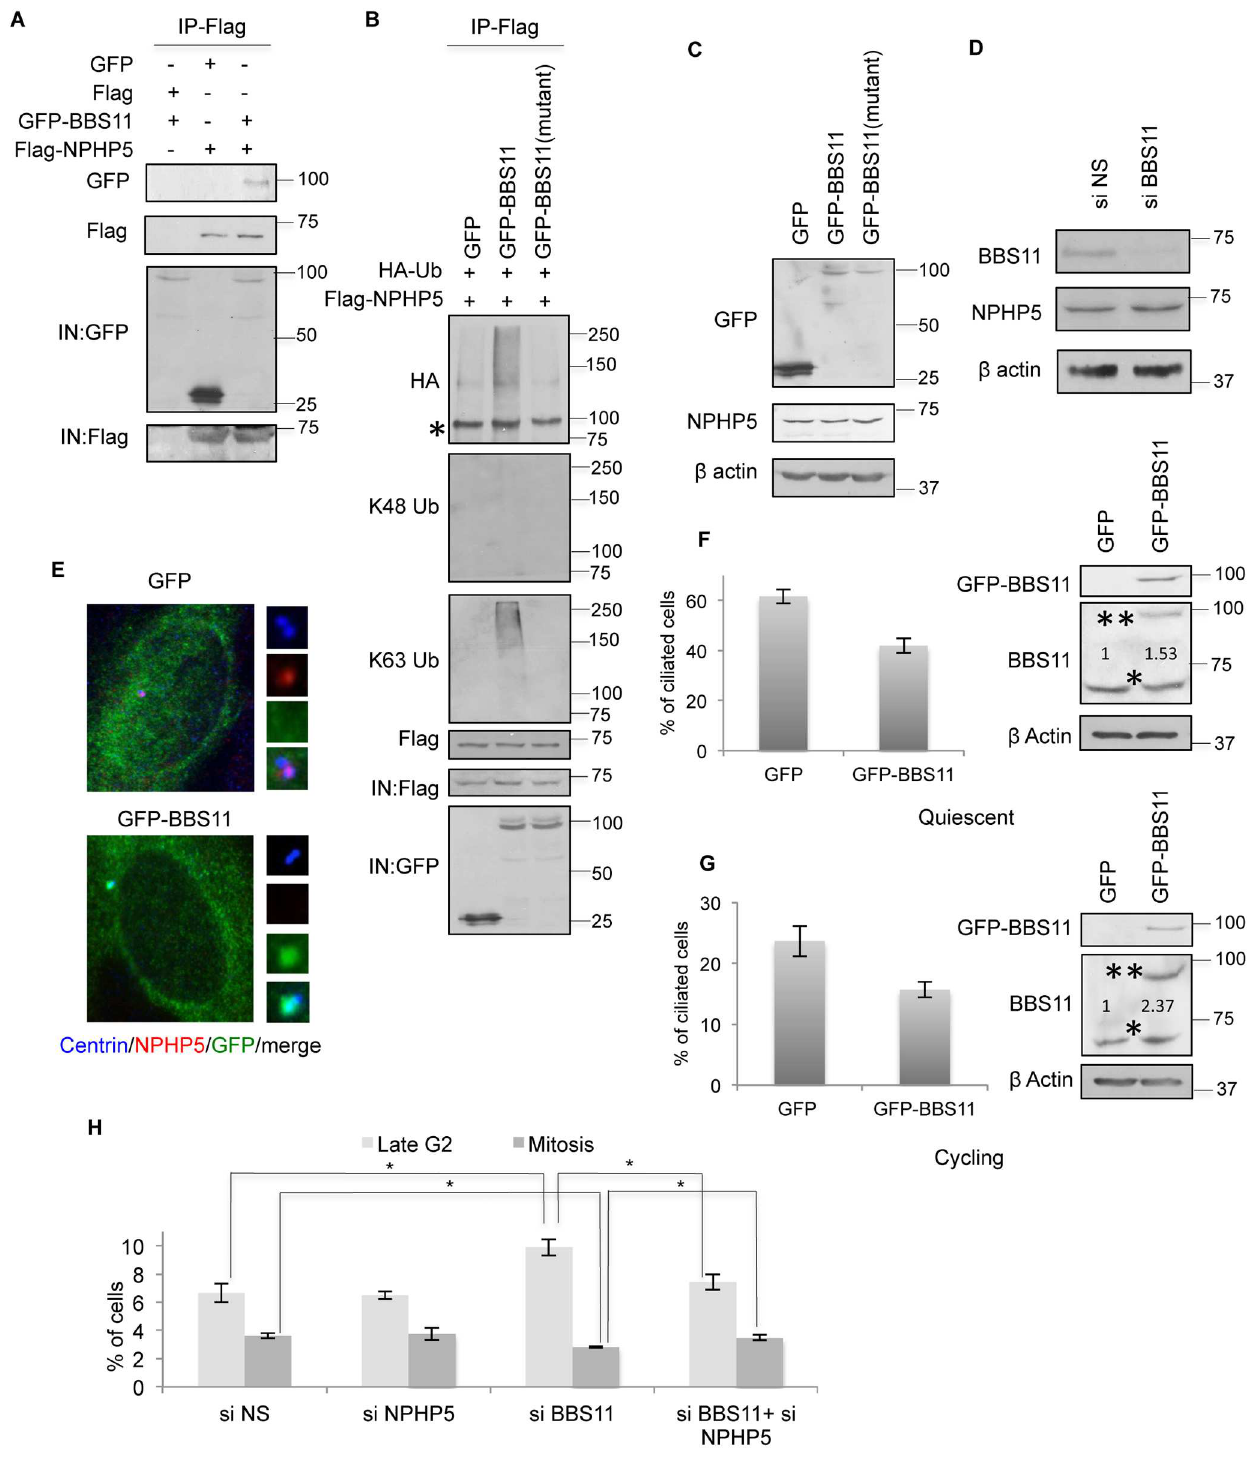
Fig 8. NPHP5 is K63 ubiquitinated by BBS11. A) Flag or Flag-NPHP5 was co-expressed with GFP or GFP-BBS11 in HEK293cells. Lysates were immunoprecipitatedwith anti-Flag antibody and Western blotted with the indicatedantibodies.IN, input. B) GFP, GFP-BBS11 wild type or catalytically inactive mutant (C20AC39AH41A; mutant) was co-expressed with Flag-NPHP5 and HA-Ub in HEK293cells. Lysates were immunoprecipitatedwith anti-Flag antibody in 1% SDS and Western blotted with the indicatedantibodies.IN, input. Asterisk indicates a non- specific band. C) HEK293cells were transfected with GFP, GFP-BBS11 wild type or mutant. Lysates were Western blotted with the